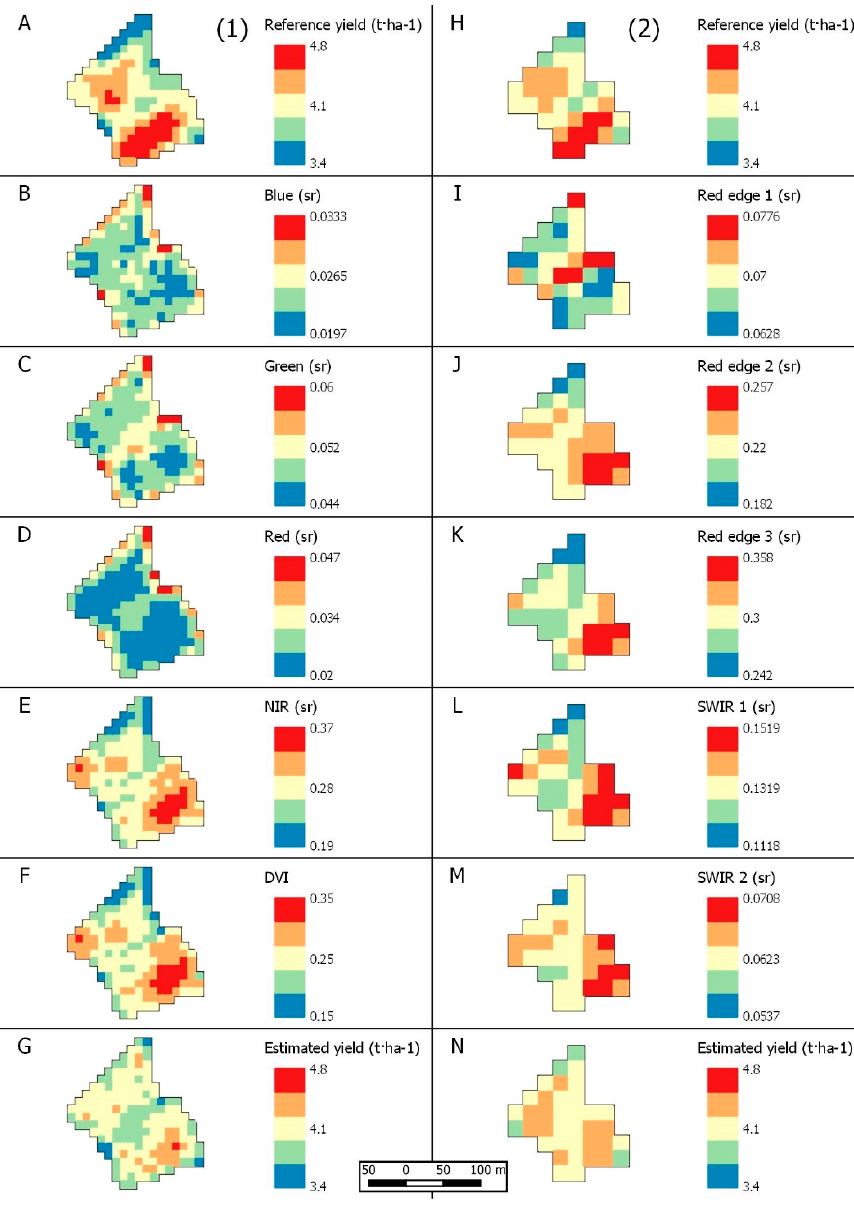
Figure A4. Example of one training Bomba field at 10 m (left, (1)) and 20 m (right, (2)) spatial resolution, being: ( A , H ) the reference yield map; ( B – F ) and ( I – M ) the SR or VI indicated at legend; ( G , N ) the modelling result (M1B+ for G and M3B+ for N).